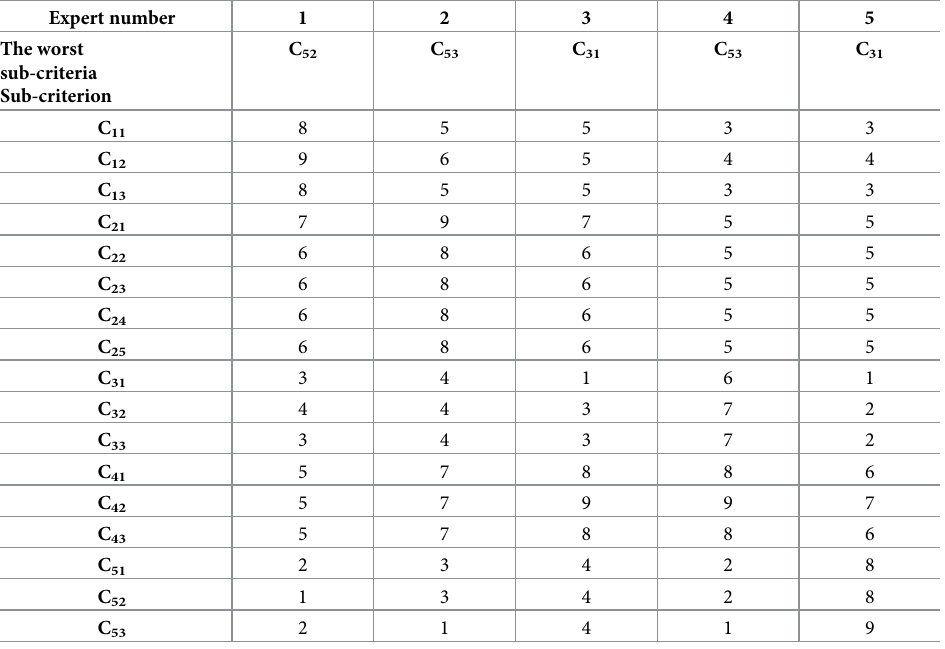
Table 6. Results of the significance comparison for others with the worst sub-criterion.